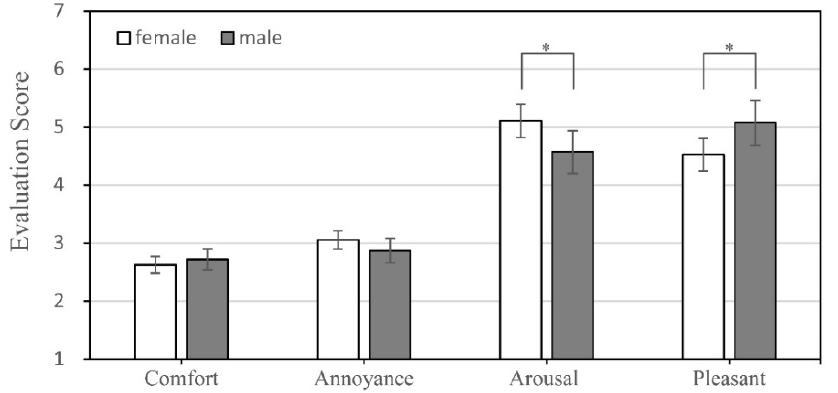
Figure 7. Effect of gender on psychological attributes. The vertical bars represent 95% confidence intervals. * represents significant differences in pair-wise comparison (LSD) at 0.05